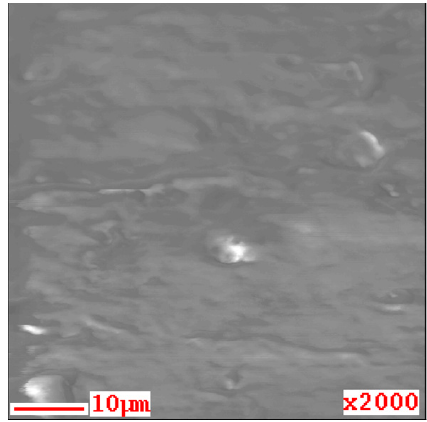
Figure 6. SEM image of the Mg(OH) 2 film.